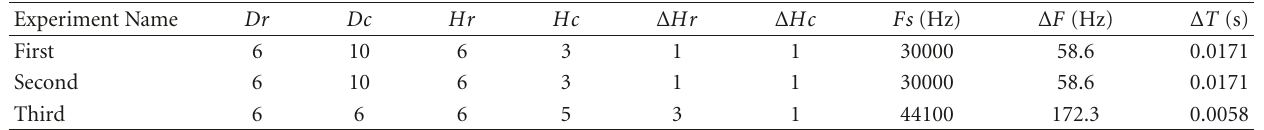
Table 1: Meta-parameters used in estimation of spectrogram features: Dr , Dc , Hr , Hc , Δ Hr , Δ Hc are number of pixels used to define TF windows of D , H , and Δ H , respectively; Δ F and Δ T show spectrogram frequency and time resolution; Fs —sampling